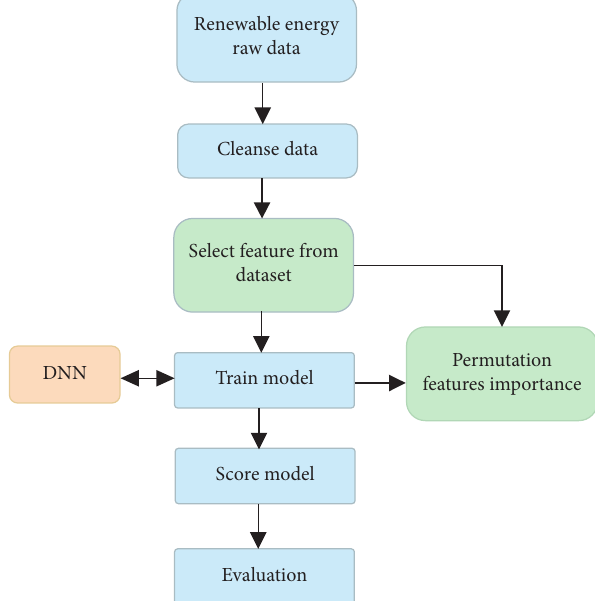
Figure 9: General flowchart of the